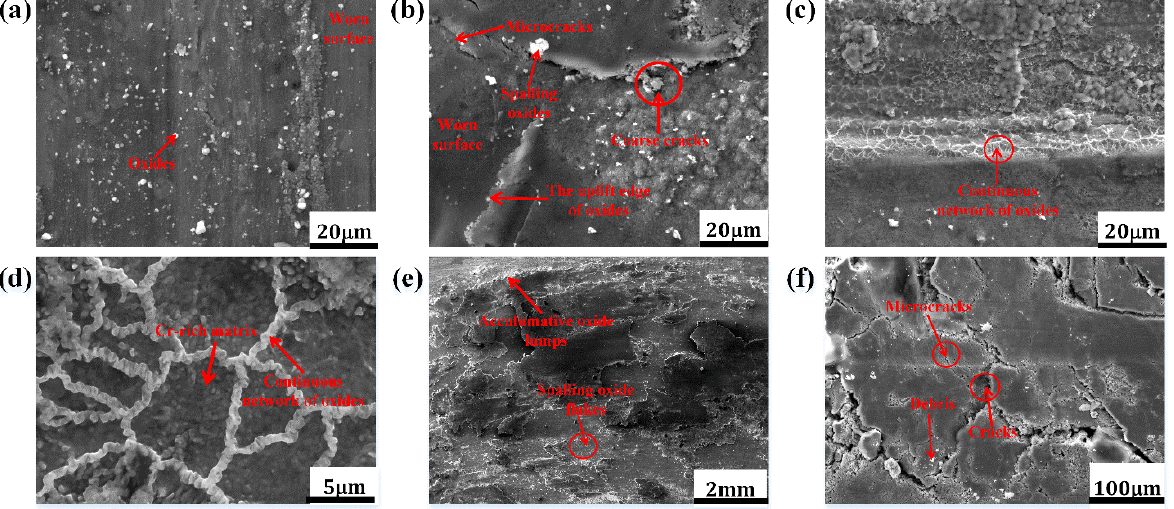
Figure 7. Surface morphologies of pin specimens and disc specimens for 50 N loads: ( a ) pin sample with 4.8 wt.% Cr at 600 °C for 50 N; ( b ) pin sample with 4.8 wt.% Cr at 800 °C for 50 N; ( c ) oxidation zone of pin sample at 800 °C for 50 N; ( d ) high-magnification oxidation zone of pin sample at 800 °C for 50 N; ( e ) surface morphologies of disc sample at low-magnification; ( f ) surface morphologies of disc sample at high magnification.